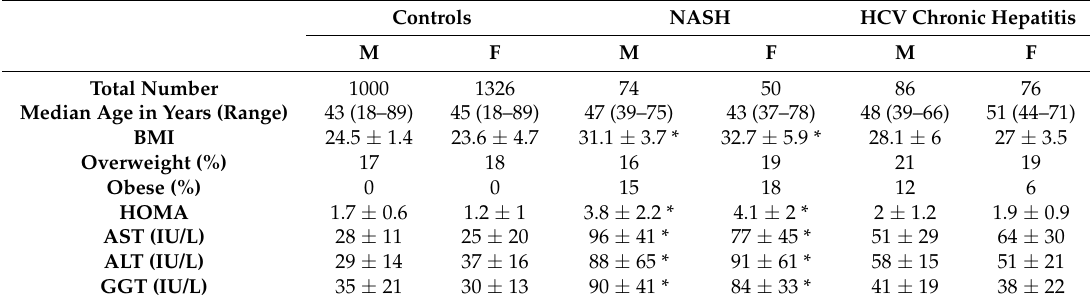
Table 1. Main demographic characteristics of controls and liver patient groups.